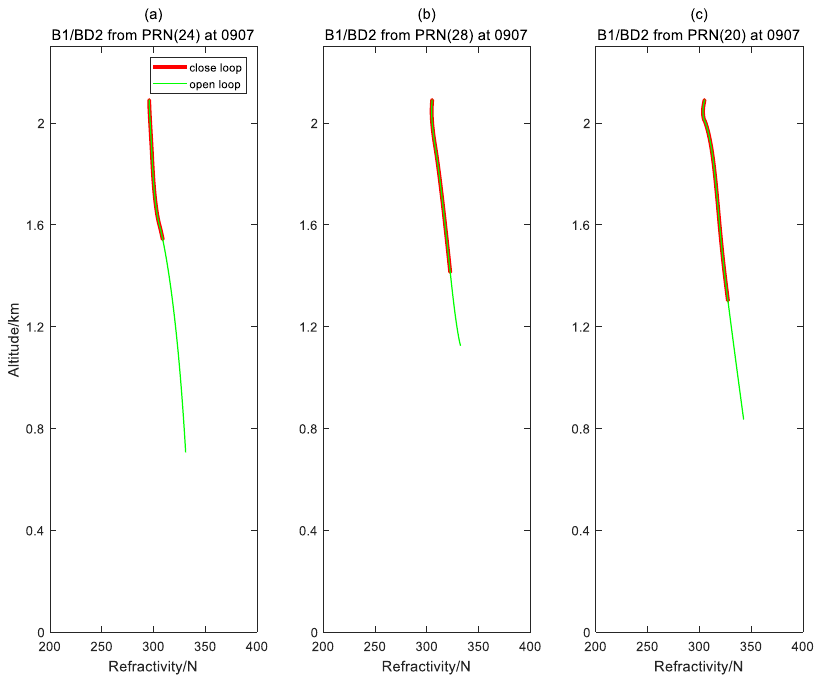
Figure 9. Refractivity profiles retrieved from observations of B1 / BD in OL / closed-loop tracking mode, respectively. Red / green lines represent results in closed- / OL mode tracking, respectively. ( a ) C24 / BD Occultation; ( b ) G28 / BD Occultation; and ( c ) C12 / BD Occultation.